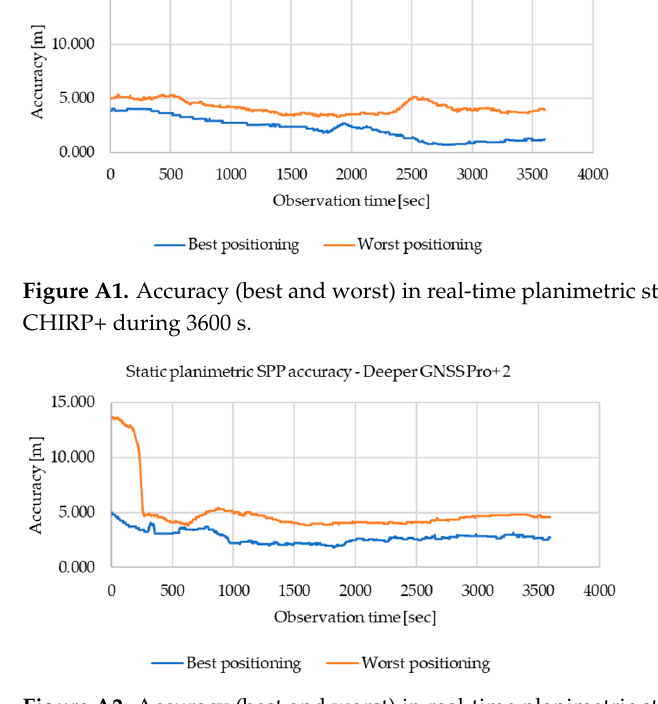
Figure A2. Accuracy (best and worst) in real-time planimetric static SPP of the Deeper Smart Sonar Pro+ 2 during 3600 s.